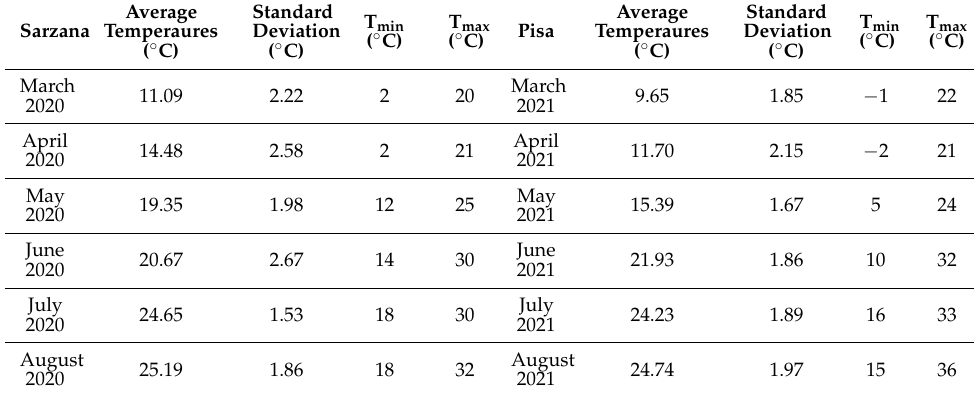
Table 4. Comparison of the air temperature data of Pisa and Sarzana. Sarzana